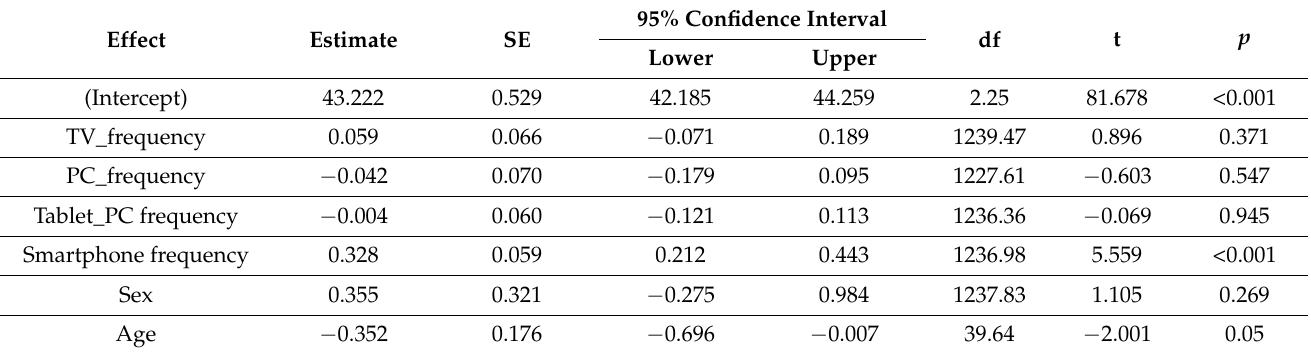
Table 4. Fixed effects parameter estimates.